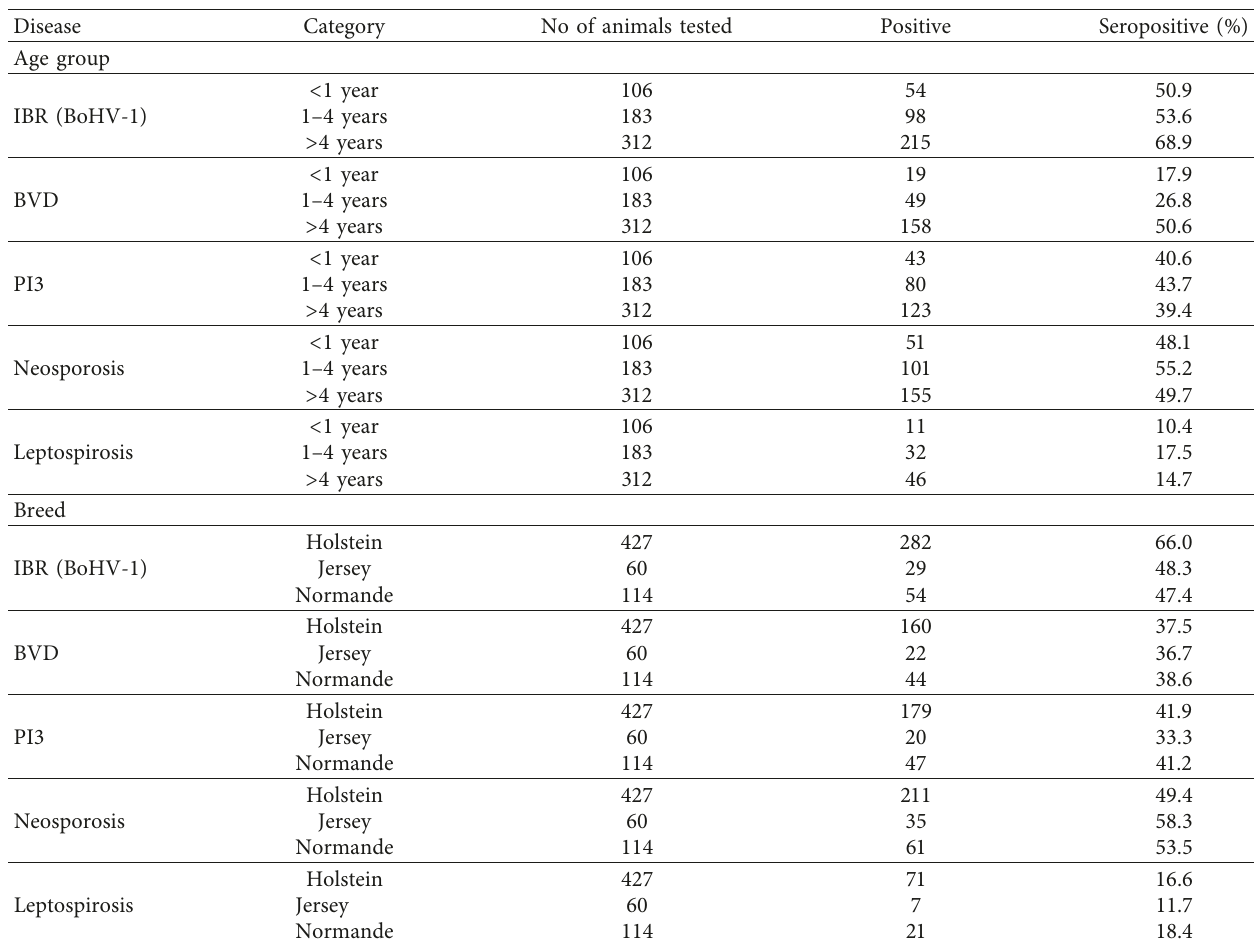
Table 1: Prevalence of IBR, BVD, PI3, neosporosis, and leptospirosis in cattle in Chiquinquir´a, Boyac´a. Disease No of animals tested BVD Neosporosis Table 2: Prevalence of IBR, BVD, PI3, neosporosis, and leptospirosis by the age group and the breed in cattle in Chiquinquir´a, Boyac´a. Disease